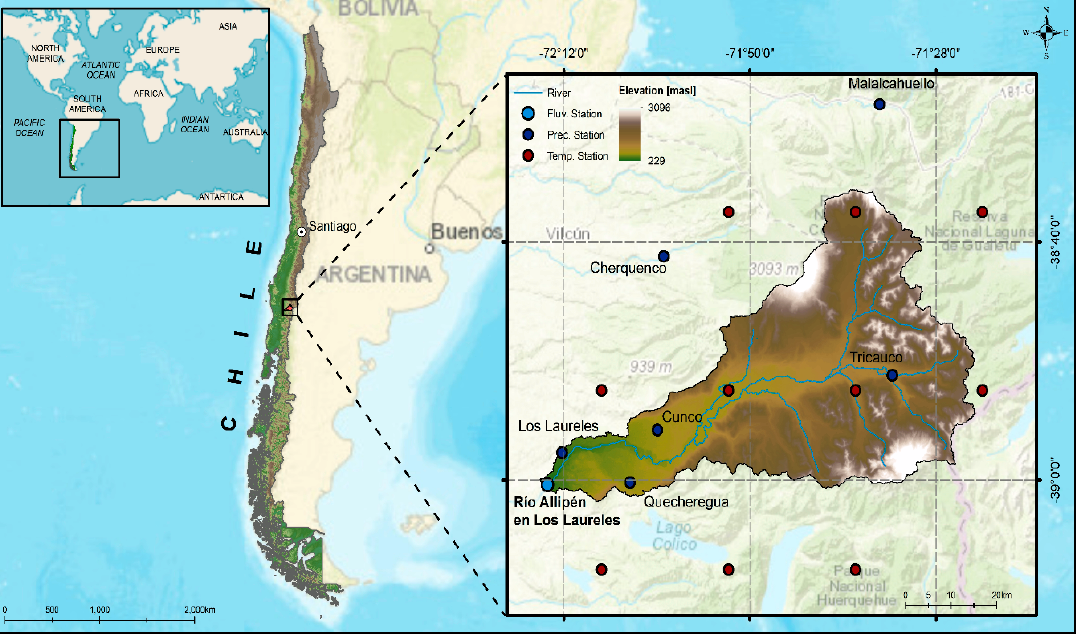
Figure 2. Map of the Allipén River watershed, Chile, and locations of the measurement stations.